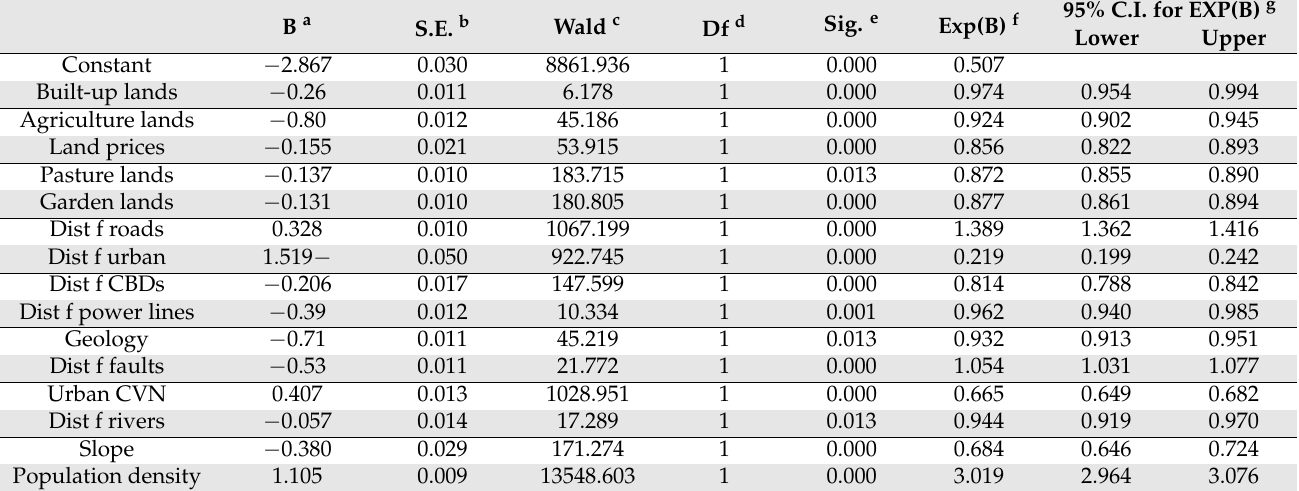
a Logistic coefficient. b Standard error of estimate. c Wald chi-square values. d Degree of freedom. e Significance. f Exponential and coefficient. g 95% confidence interval for Exp(B).